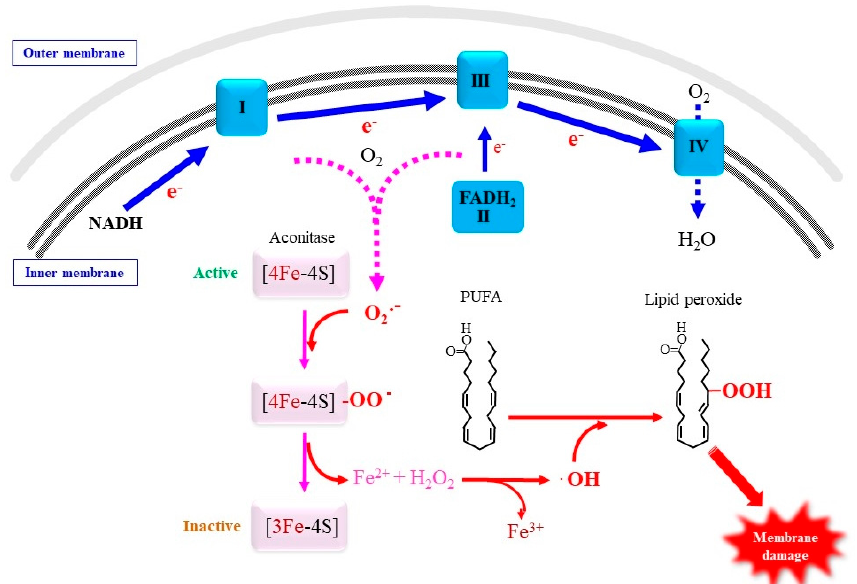
Figure 3. Proposed role of superoxide in mitochondrial membrane damage. Superoxide that is released from the ETC under ferroptotic stimuli may become attached to 4Fe-4S clusters in proteins, notably aconitase, which results in the release of ferrous iron and hydrogen peroxide. PUFA in mitochondrial membrane undergoes peroxidation by ROS and consequently destructs mitochondrial membrane integrity.